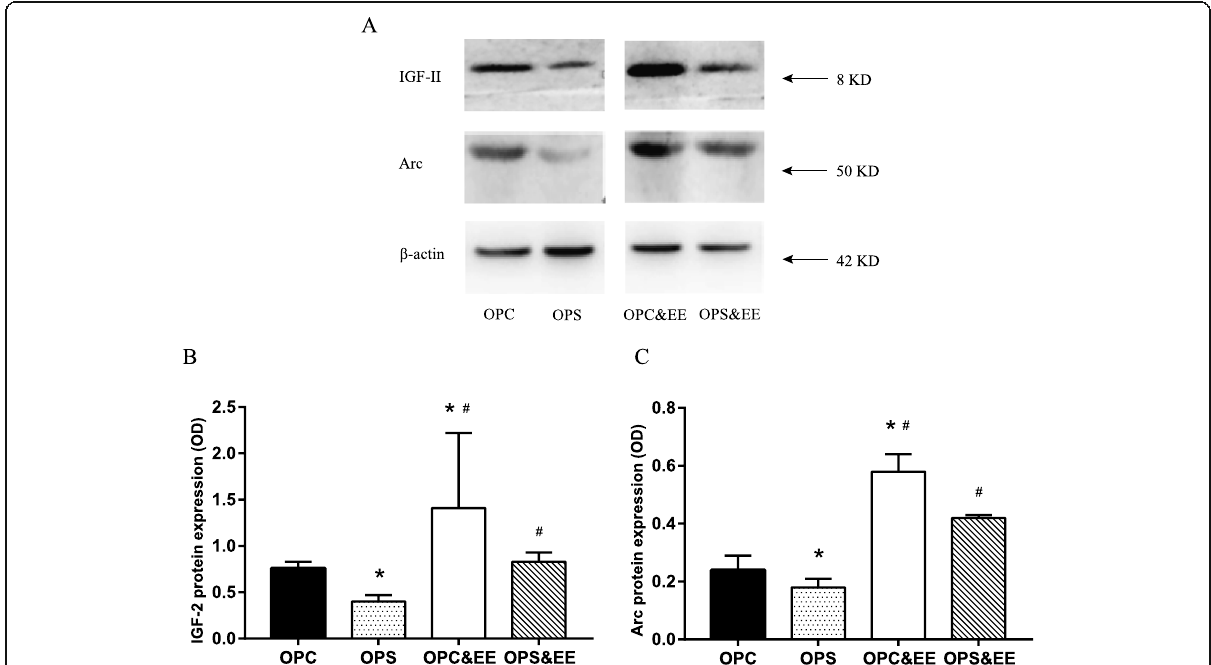
Fig. 8 The effects of enriched environment on the hippocampal IGF-2 and Arc protein expression in the offspring due to maternal stress of pregnancy. Differences in IGF-2 and Arc protein expression in the hippocampus were detected among four groups. The IGF-2 and Arc protein expression of PS offspring were lower than that of PC offspring; however, they were increased by EE. Data were respectively analyzed using One- way ANOVA, followed by LSD-t test to make comparison at the two different groups. Number of samples in each offspring group = 4 (50% male, 50% female) ( a Electrophoresis results of IGF-2 and Arc protein expression in offspring. b IGF-2 protein expression in the hippocampus of offspring. c Arc protein expression in the hippocampus of offspring. * P < 0.05 vs. OPC. # P < 0.05 vs.